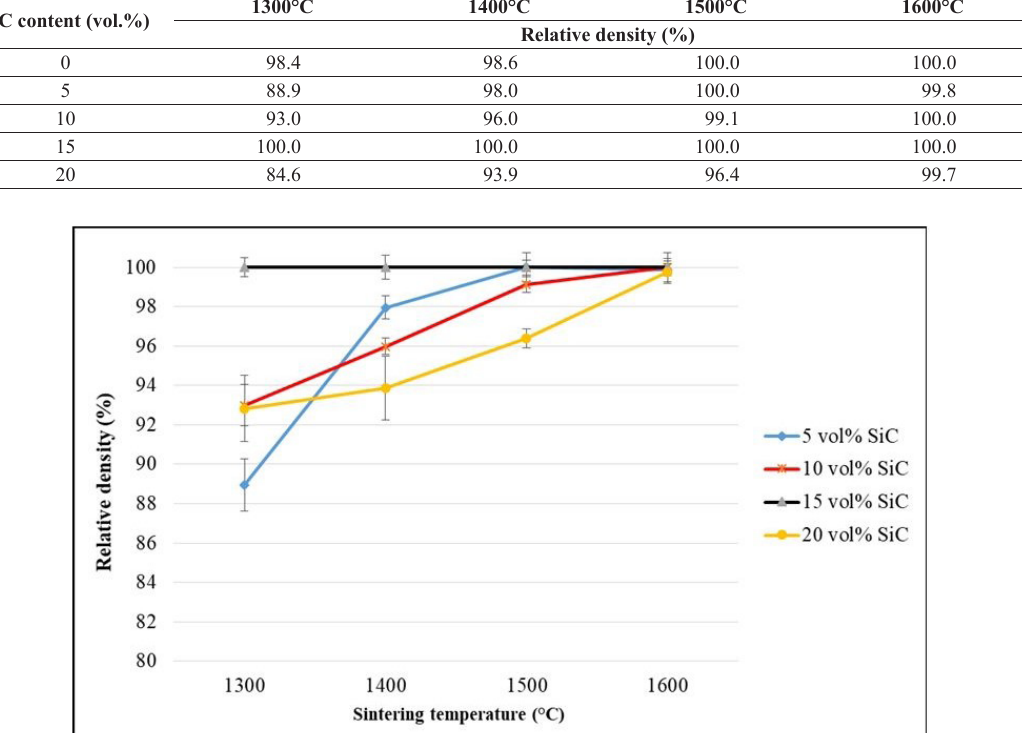
O -SiC materials as a function of sintering temperature and SiC content 2 3